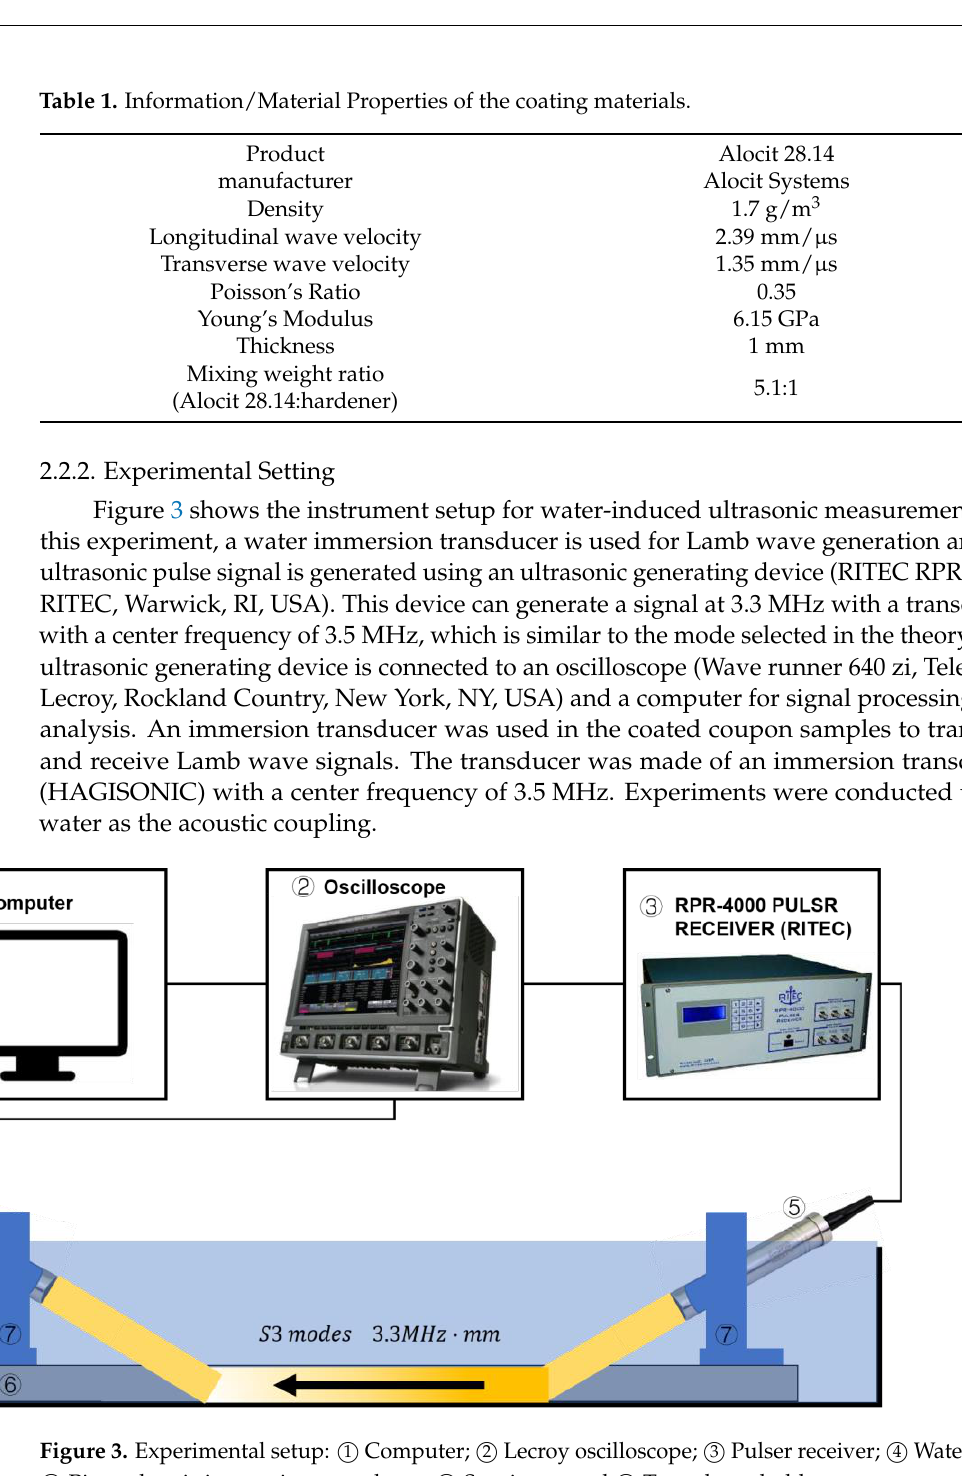
Figure 4. Guided Wave Generation Experiments in Water: ( a ) top view;( b ) front view. The symmetric S3 modes 3.3 MHz ∙ mm wave pattern was successfully generated, as shown in Figure 5. The wave propagation distances are 60 mm, 70 mm, and 80 mm in